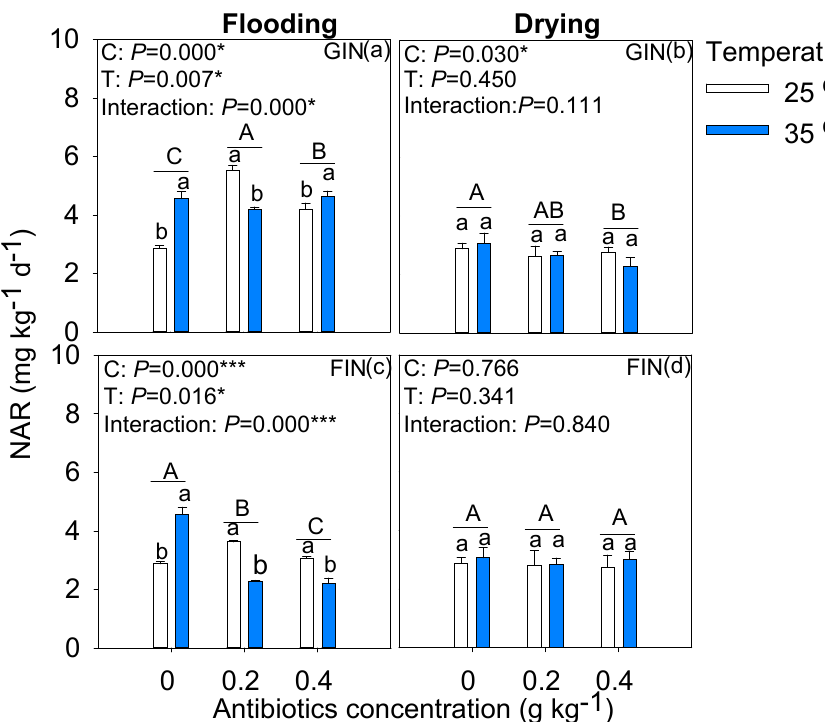
Figure 3. Net ammonification rate (NAR) with the antibiotics content of 0, 0.2 and 0.4 g kg − 1 in the flooding and drying conditions at 25 °C and 35 °C. Different uppercase letters indicate significant differences among antibiotics concentrations of 0, 0.2 and 0.4 g kg − 1 . Different lowercase letters represent significant differences between 25 and 35 °C at the same antibiotic concentration ( p < 0.05). Different numbers of asterisks represent a significant difference (* p < 0.05, *** p < 0.001).